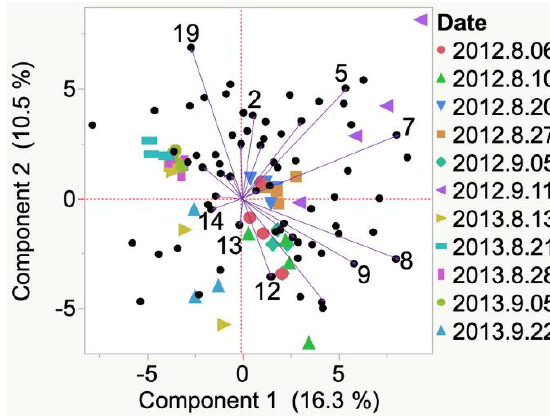
Figure 10. Evolution of VOCs emitted from crushed berries from veraison to harvest of 2012 and 2013 Marquette grapes grown in South Dakota. Key to most representative volatiles from HCA, shown as vectors from the origin and read clockwise: 1 = 1-Heptanol, 2 = Amyl acetate, 3 = Methyl ethyl ketone, 4 = Decane, 5 = Styrene, 6 = beta-Cyclocitral, 7 = Nonanal, 8 = Acetaldehyde, 9 = Valeraldehyde, 10 = Octanal, 11 = Cyclohexanol, 12 = ( E )-2-hexenoic acid, 13 = Methyl disulfide, 14 = Nonane, 15 = Allyl alcohol, 16 = beta-Damascenone, 17 = Nerol acetate, 18 = p -cymene, 19 =